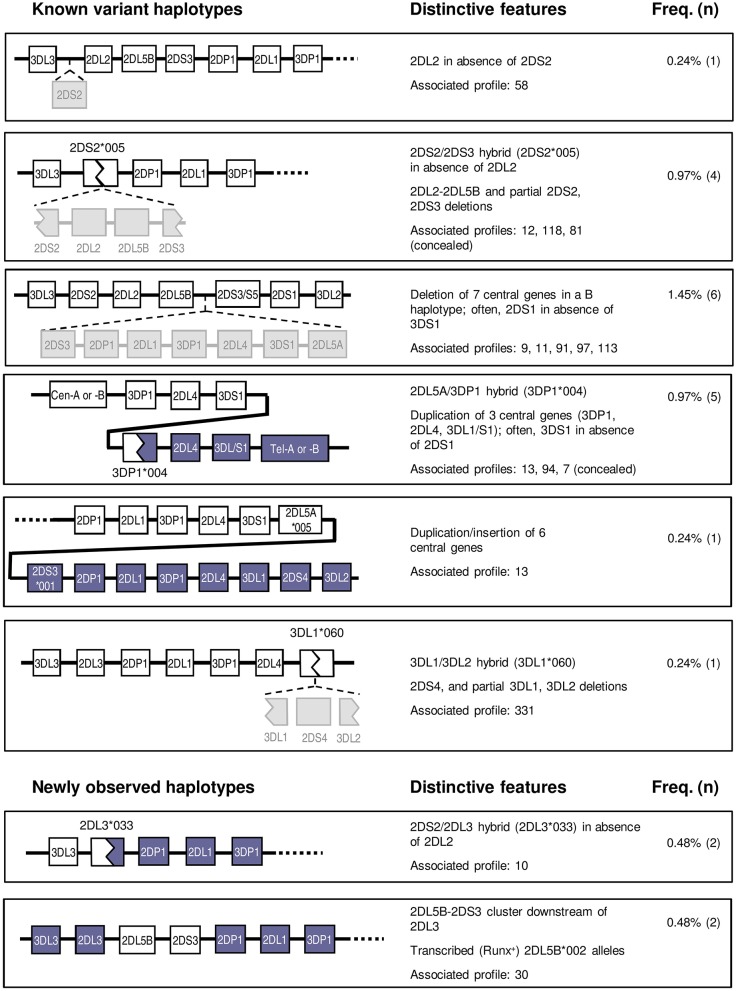
Variant and novel haplotypes detected in Spanish individuals. Colors are used to highlight gene deletions and hybrid structures derived from recombination of two different genes or haplotypes, but they lack a specific meaning. Duplicated genes are represented in parallel.